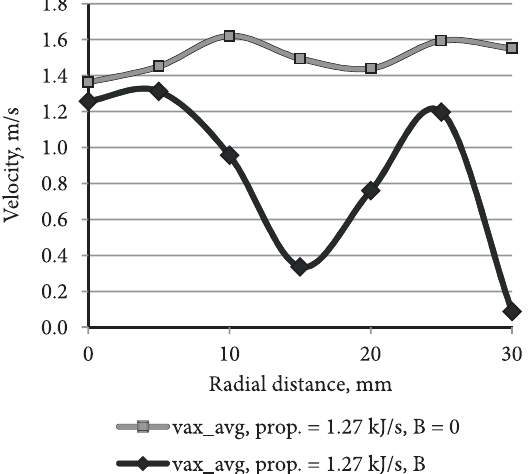
Fig. 8. Effect of magnetic field on formation of flame axial (a) and tangential (b) velocity distribution in the process of co-